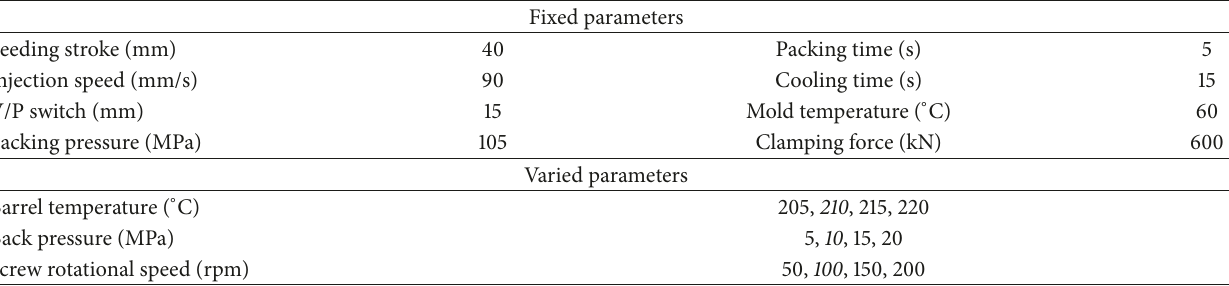
Table 6: Process parameter settings for varied plasticizing parameters